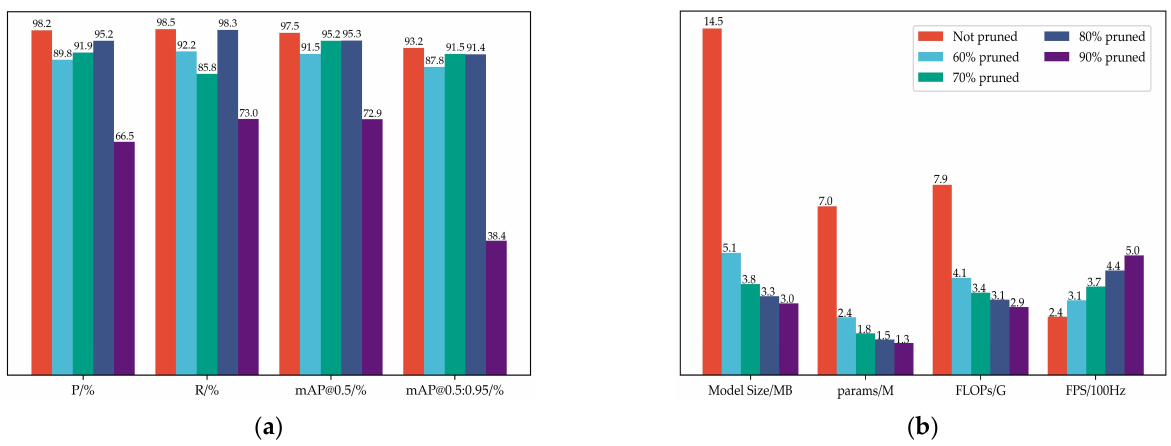
Figure 13. Performance of YOLO-slimming with different pruning ratios. ( a ) Accuracy; ( b ) Complexity.